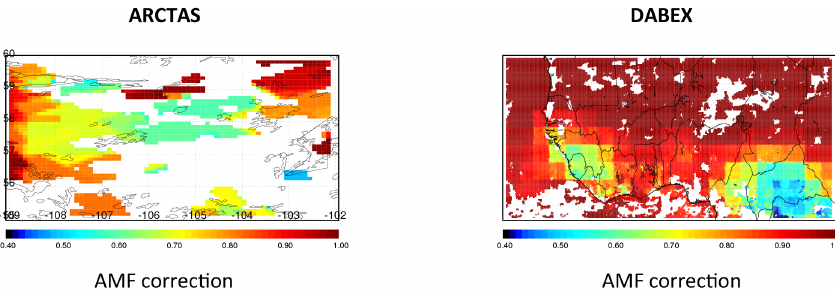
Figure 2. Mean AMF shape factor correction over Canadian fires during ARCTAS (30 June–10 July 2008) (left) and West African fires during DABEX (13 January–2 February 2006) (right). Retrievals with a cloud fraction > 5% have been excluded.